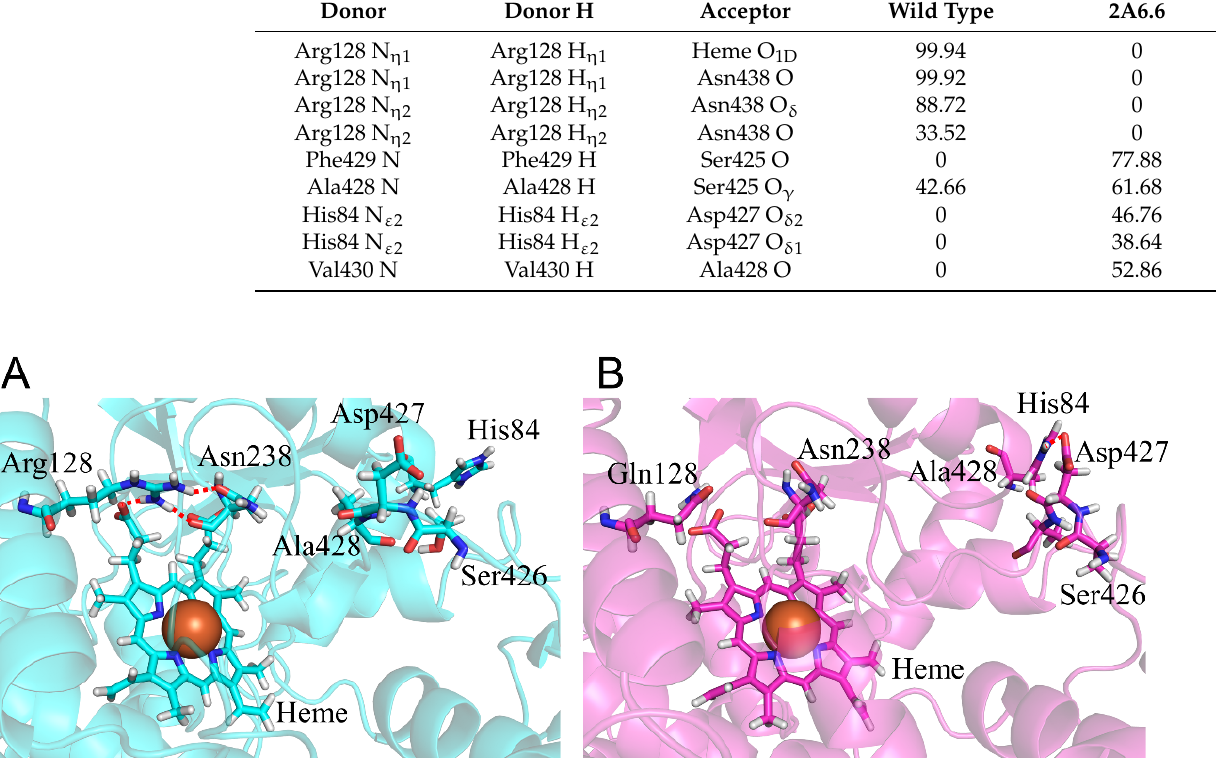
Figure 5. Structural change in CYP2A6.6. The wild type ( A ) and CYP2A6.6 ( B ) are shown in cyan and magenta, respectively. Nitrogen, oxygen, and hydrogen are displayed in blue, red, and white, respectively, in the stick model. Iron is shown as an orange sphere by a model written as the van der Waals radius. The red dotted lines indicate the hydrogen bonds.